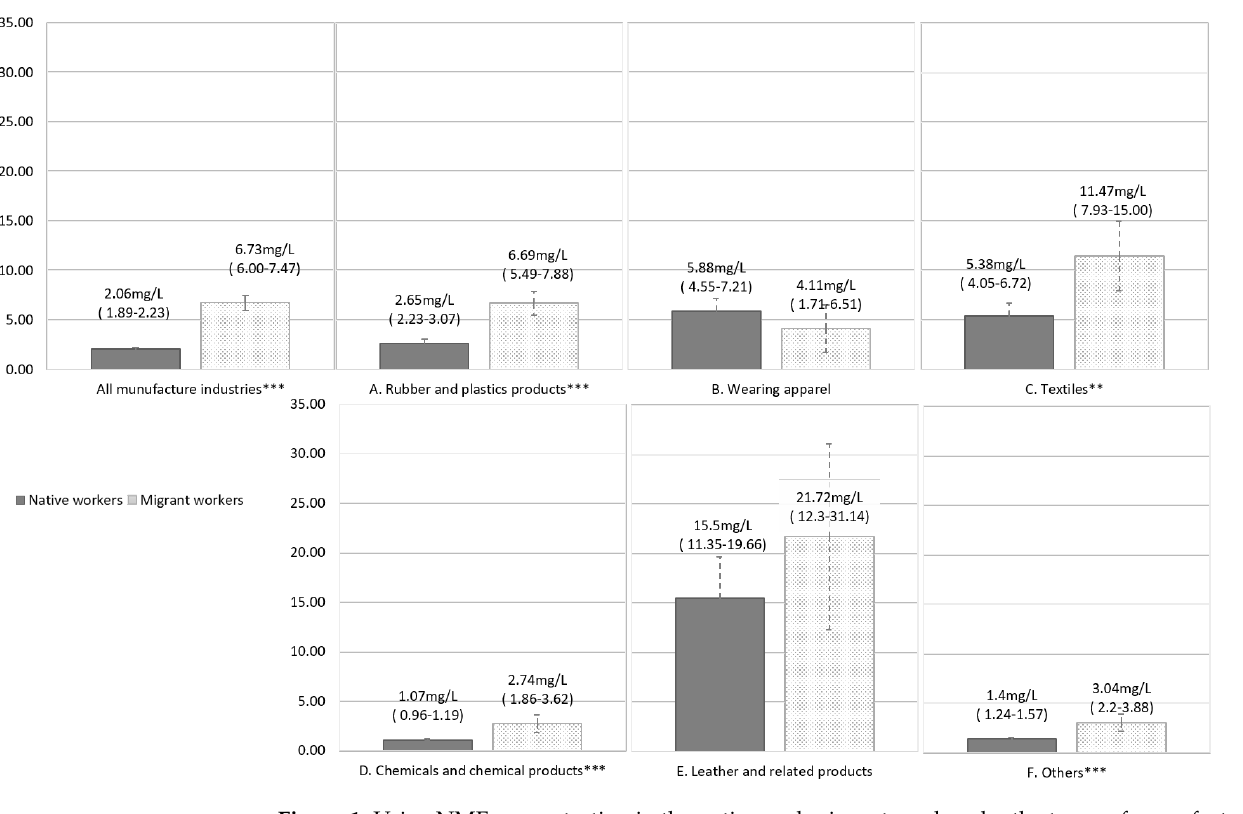
Figure 1. Urine NMF concentration in the native and migrant workers by the types of manufacture industries. ( A – F ) show the urine NMF concentrations by the native and migrant workers in the manufactures of rubber and plastics products, wearing apparels, textiles, chemicals and chemical products, leather and related products and other manufacturing industries, respectively. Estimated marginal means (95% confidence intervals) were calculated using generalized linear model. Non- detected values under LOD or those recorded as “0” were calculated by substitution with half of the minimally detected value (=0.0005 mg/dL). **, p < 0.01; ***, p < 0.001; NMF = N′ -methylformamide; LOD = limit of detection. Table 2. Risk of urine concentration of N (cid:48) -methylformamide > 30 mg/L among the workers.